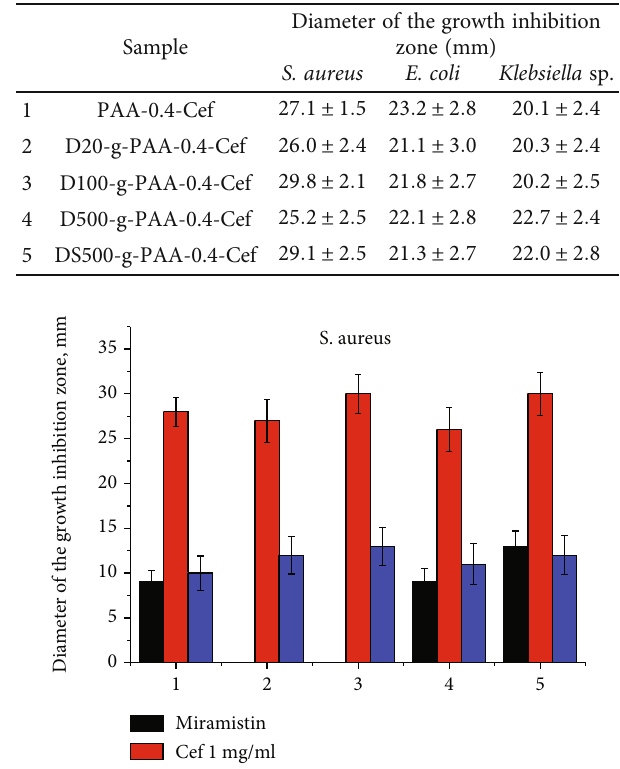
Table 4: Antimicrobial activity of cefuroxime-loaded hydrogels swollen in 1mg/mL antibiotic solution.